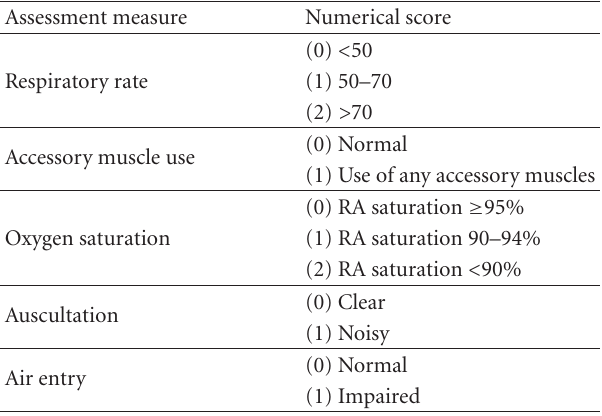
Table 1: Bronchiolitis severity score.